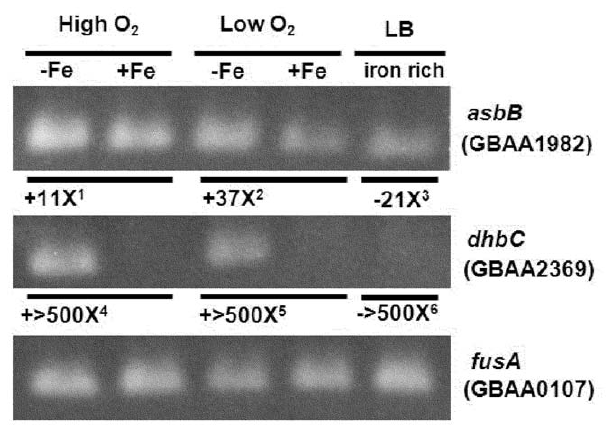
Figure 6. End-Point RT-PCR and SYBR-Green qRT-PCR of select genes from the asb and bac operons in iron-depleted, iron- supplemented, and iron-rich conditions. Ethidium bromide stained agarose gels from endpoint RT-PCR of the second gene in the